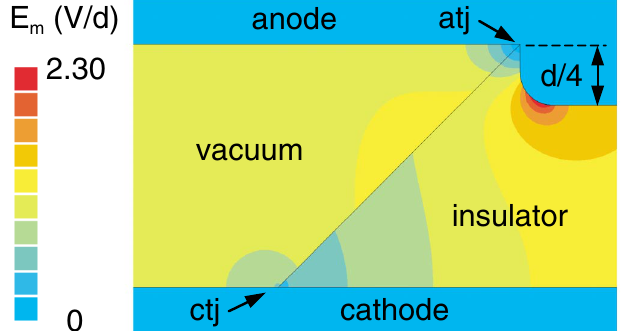
FIG. 7. (Color) The absolute value of the electric-field magni- as a function of position for an idealized 2D 45 (cid:1) tude E m vacuum-insulator interface with a d= 4 anode plug. The figure assumes that the dielectric constant of the insulator " (cid:8) 2 : 55 . The anode triple junction (atj) is the point at which the vacuum, insulator, and anode regions meet; the cathode triple junction (ctj) is similarly defined. The color legend is a linear scale. The field magnitude is given in units of V=d , where V is the voltage across the insulator and d is the insulator thickness as defined by Fig. 1. Comparing Figs. 2 and 7, it is clear that the plug decreases significantly the field at the anode triple